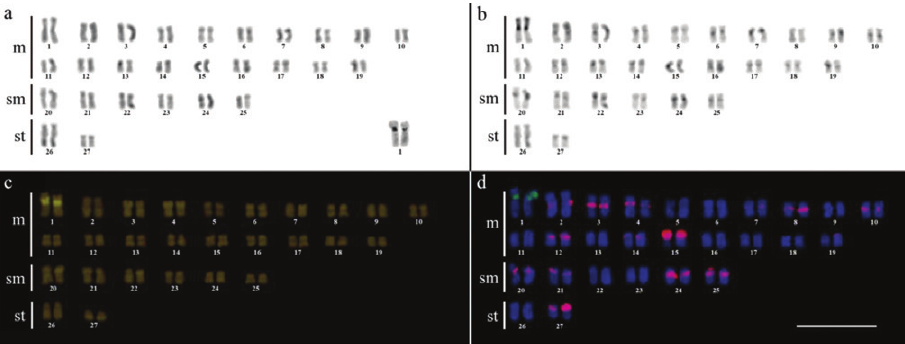
Figure 4a–d. Karyotype of G . pantherinus after ( a ) conventional Giemsa staining, ( b ) C-banding, ( c ) CMA fluorochrome staining, ( d ) double FISH with 5S rDNA (green) and 18S rDNA (red) probes. Bar = 10µm.